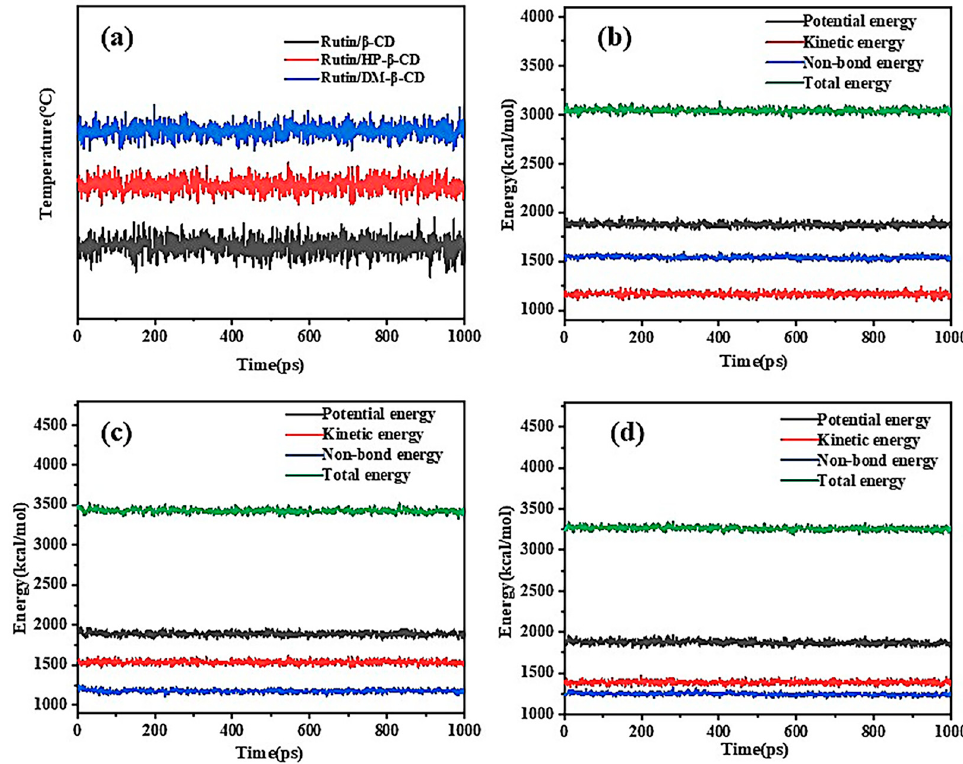
Figure 10. ( a ) Temperature equilibrium diagram of three inclusion complexes; ( b ) energy balance diagram of rutin/ β -CD inclusion complex; ( c ) energy balance diagram of rutin/HP- β -CD inclusion complex and ( d ) energy balance diagram of rutin/DM- β -CD inclusion complex.